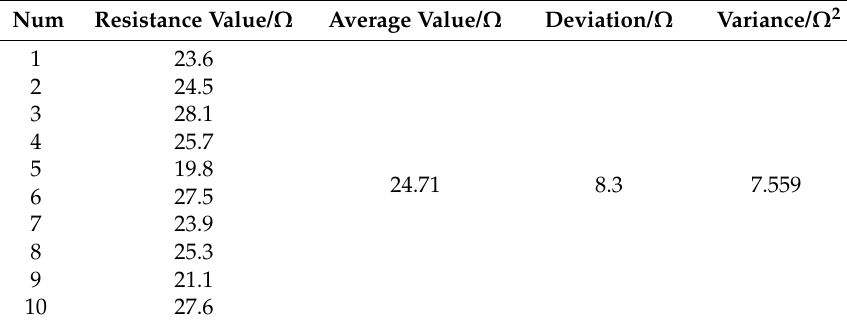
Table 2. The resistance of the conventional welded amorphous wire magnetic sensors. Num